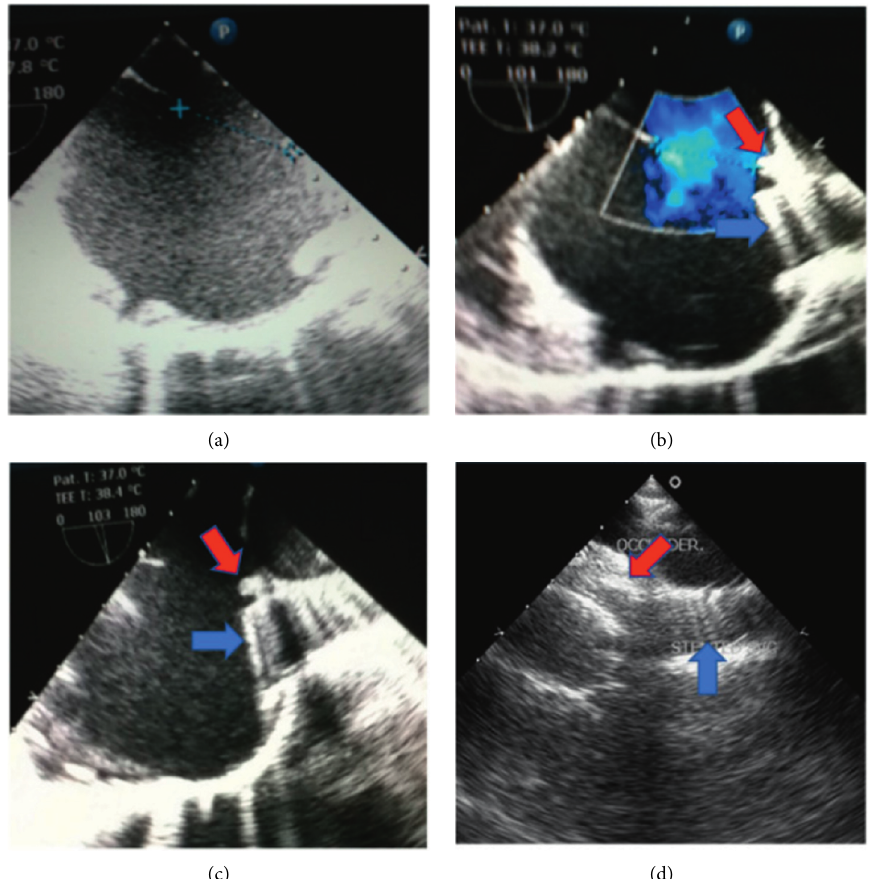
Figure 2: (a) TEE imaging in long-axis bicaval view demonstrates a large secundum ASD with an absent superior rim. (b, c) TEE imaging in long axis bicaval view demonstrates large secundum ASD with color follow mapping after inflation of the covered CP-stent creating a new superior rim (red arrow) with the clear struts of the stent (blue arrow). (d) TEE imaging in modified long axis bicaval view clearly demonstrates the struts of the covered CP-stent (blue arrow) creating a new superior rim (red arrow) which has been captured by two discs of the Occlutech septal occluder size 40mm (red